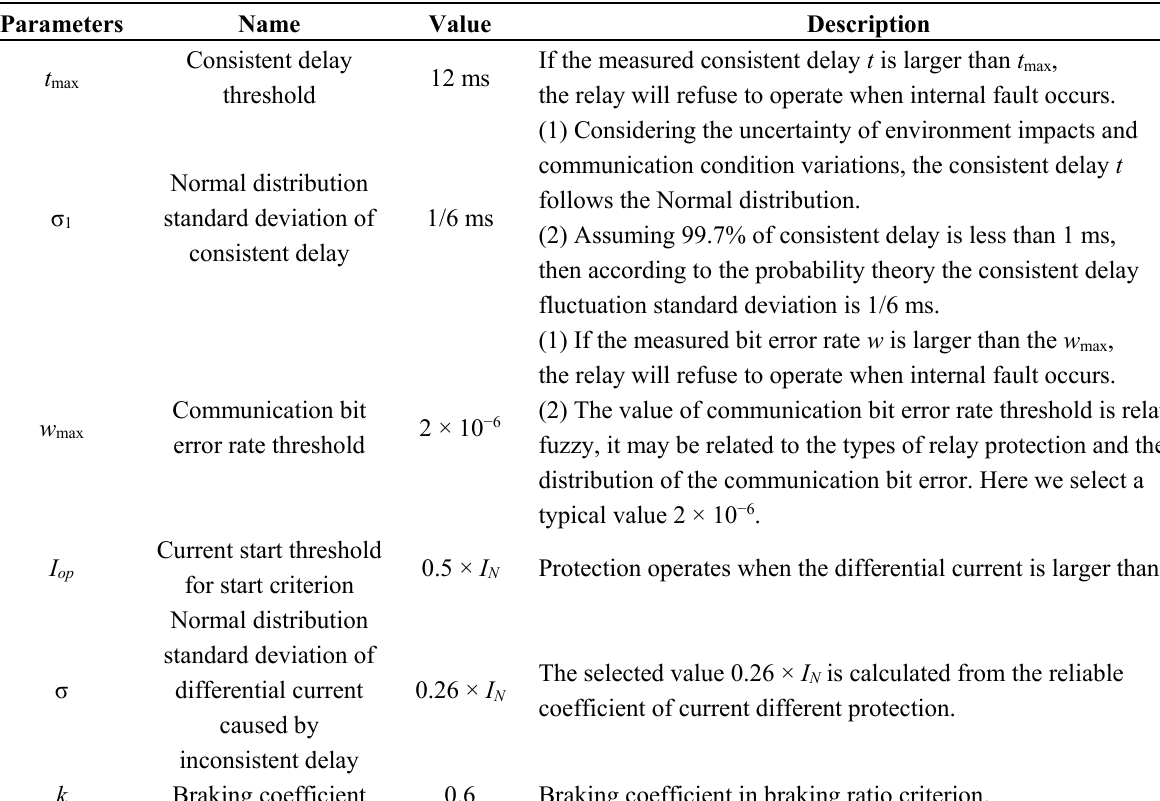
Table 1. Parameters used in the